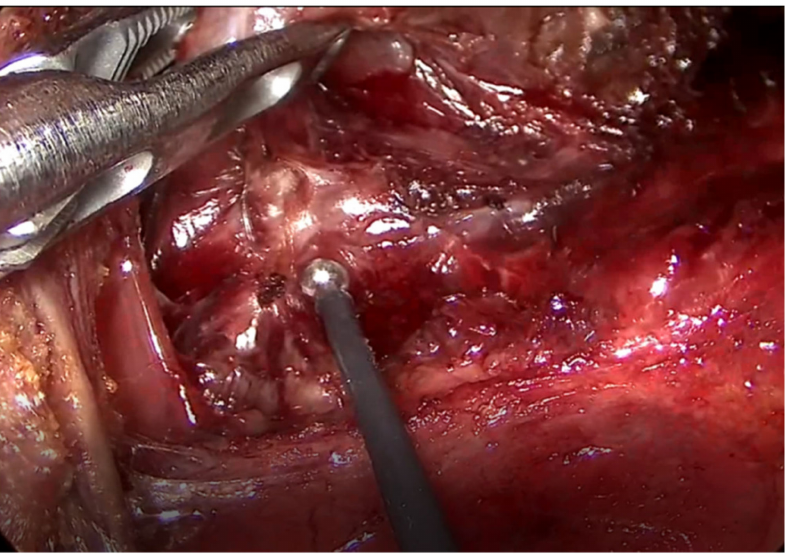
Figure 3. External branch of the superior laryngeal nerve monitoring using a long ball-tip monopolar stimulation probe.